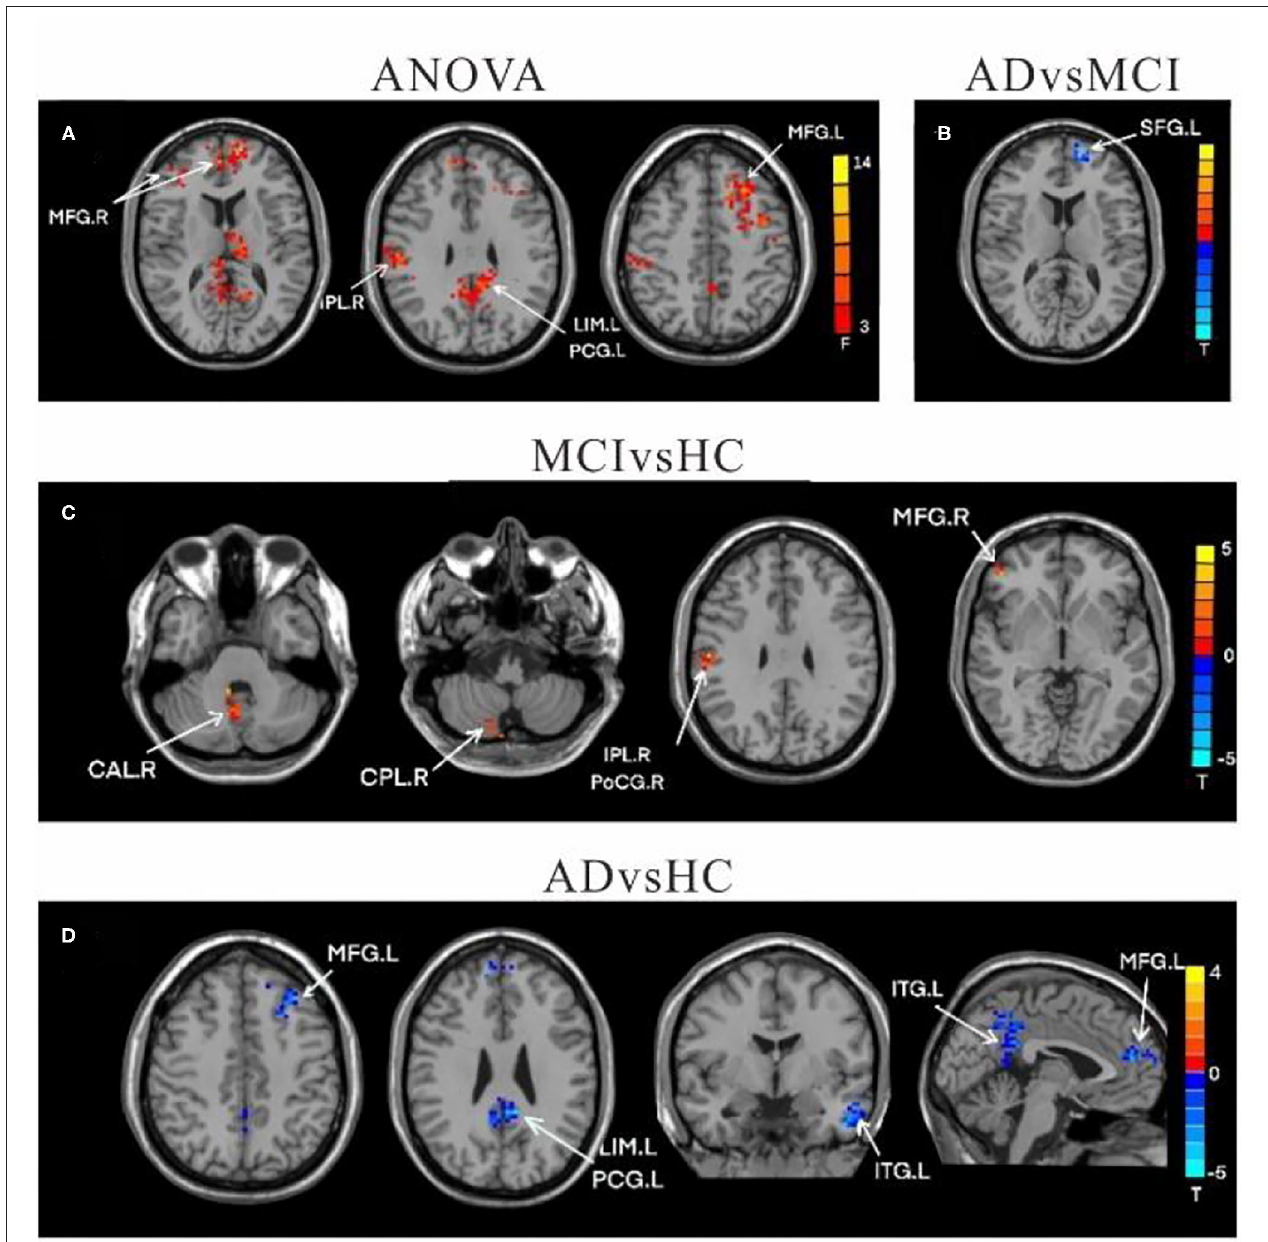
FIGURE 5 | Differences of FC values in the cerebellum right lobule IX. (A) Brain regions showing significant differences in FC of the right lobule IX based on analysis of variance (ANOVA) analysis between HC, AD, and aMCI; p < 0.05, the cluster size > 100 voxels. (B–D) The results of post-hoc two-sample T -tests in voxel-wise analysis (Bonferroni corrected, cluster size ≥ 30 voxels, p < 0.05). AD, Alzheimer’s disease; aMCI, amnestic mild cognitive impairment; HC, healthy controls; MFG, Middle Frontal Gyrus; IPL, inferior parietal lobe; LIM, limbic lobe; PCG, posterior cingulate gyrus; SFG, superior frontal gyrus; CAL, cerebellum Anterior lobe; CPL, cerebellum posterior lobe; THA, Thalamus; ITG, inferior temporal gyrus; CAU, Caudate; L, left; R,